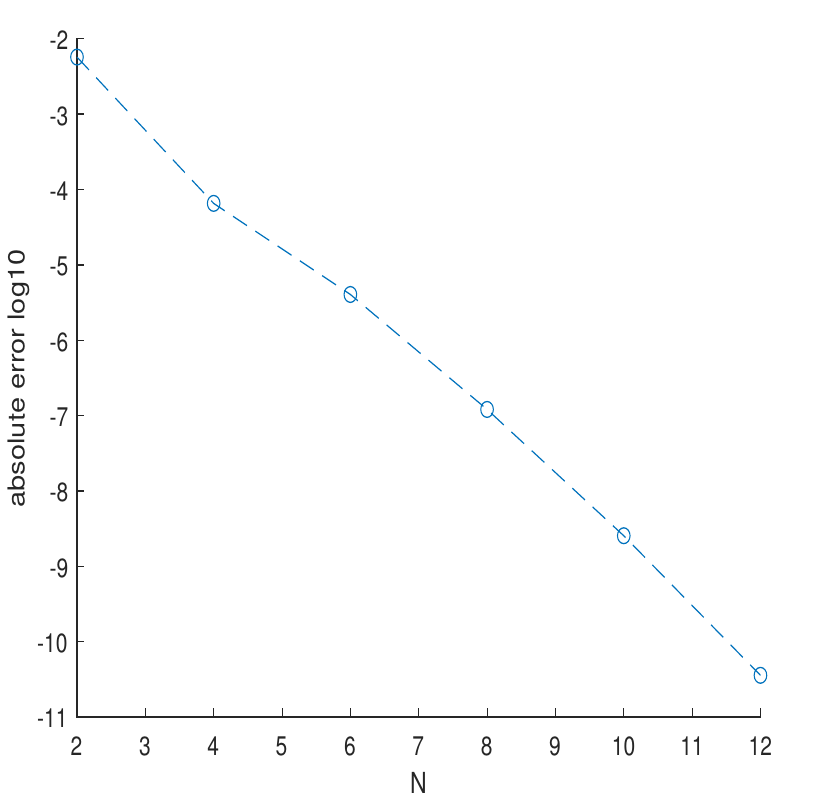
Figure 4. Log 10 of the absolute error versus N at ν = 1 for Example 3.